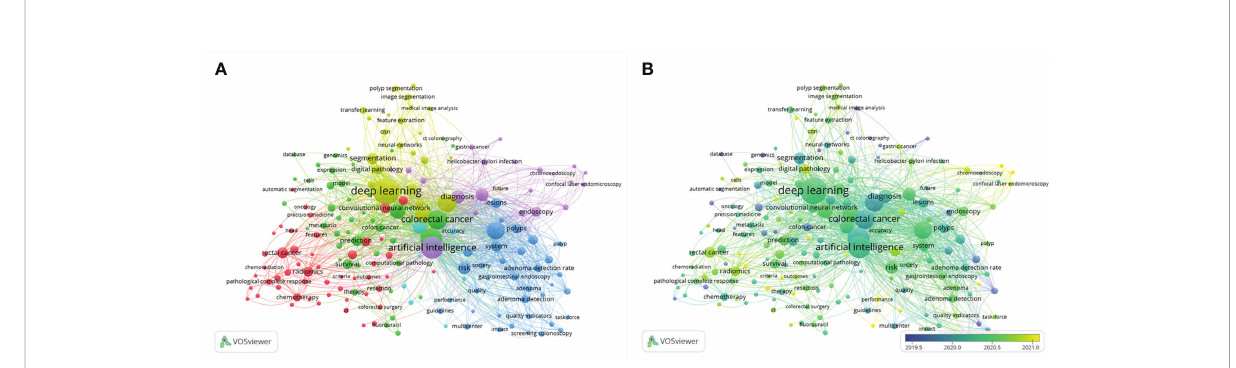
FIGURE 7 Network visualization (A) and overlay visualization map (B) of the keywords co-occurrence analysis by VOS viewer.